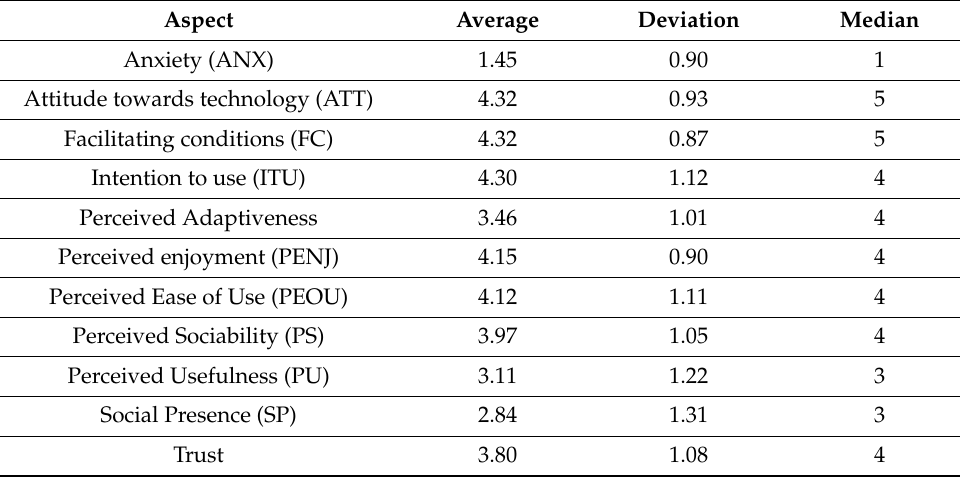
Table 1. Results of the questionnaires from the adult users’ tests.